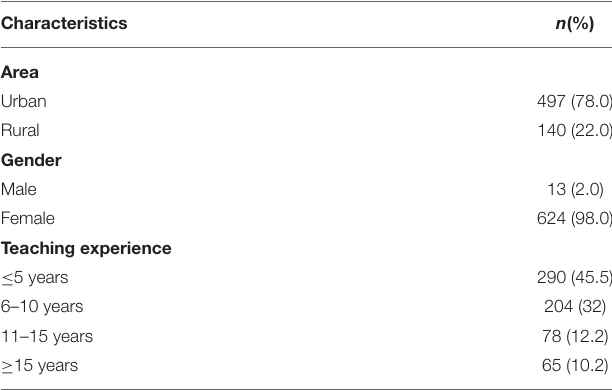
TABLE 1 | Demographic information of the sample ( n =